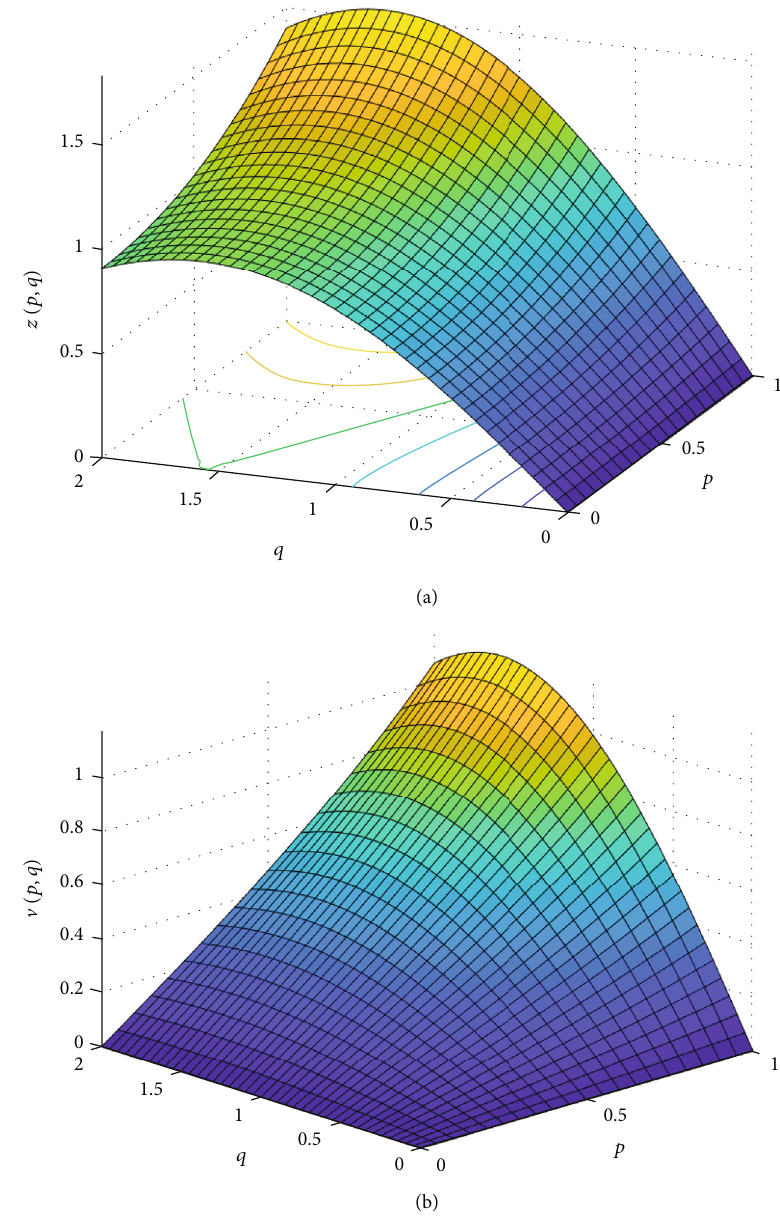
Figure 3: Numerical solution of z ð p , q Þ , v ð p , q Þ with ρ = ω = υ = 1 for Example 8 when m = 6